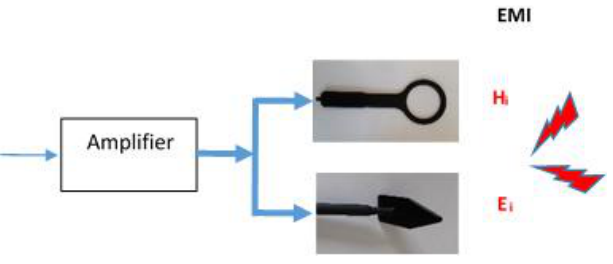
Figure 15. Realization of special electric and magnetic field probes.